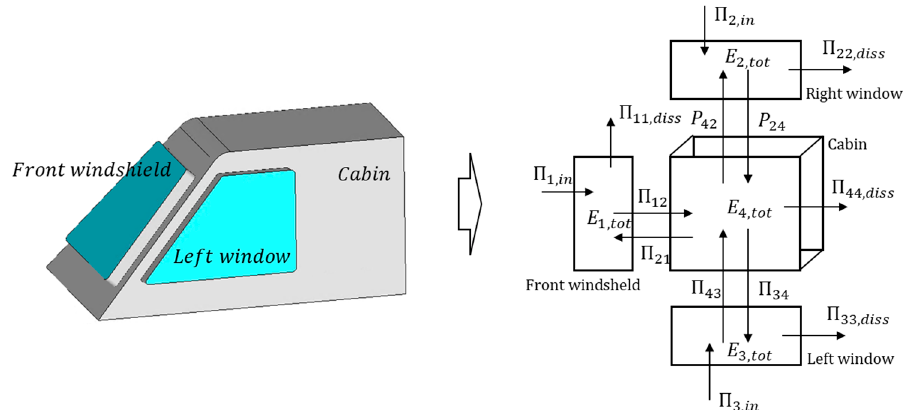
Figure 17. Power flow in four subsystems of SEA model for HSM.